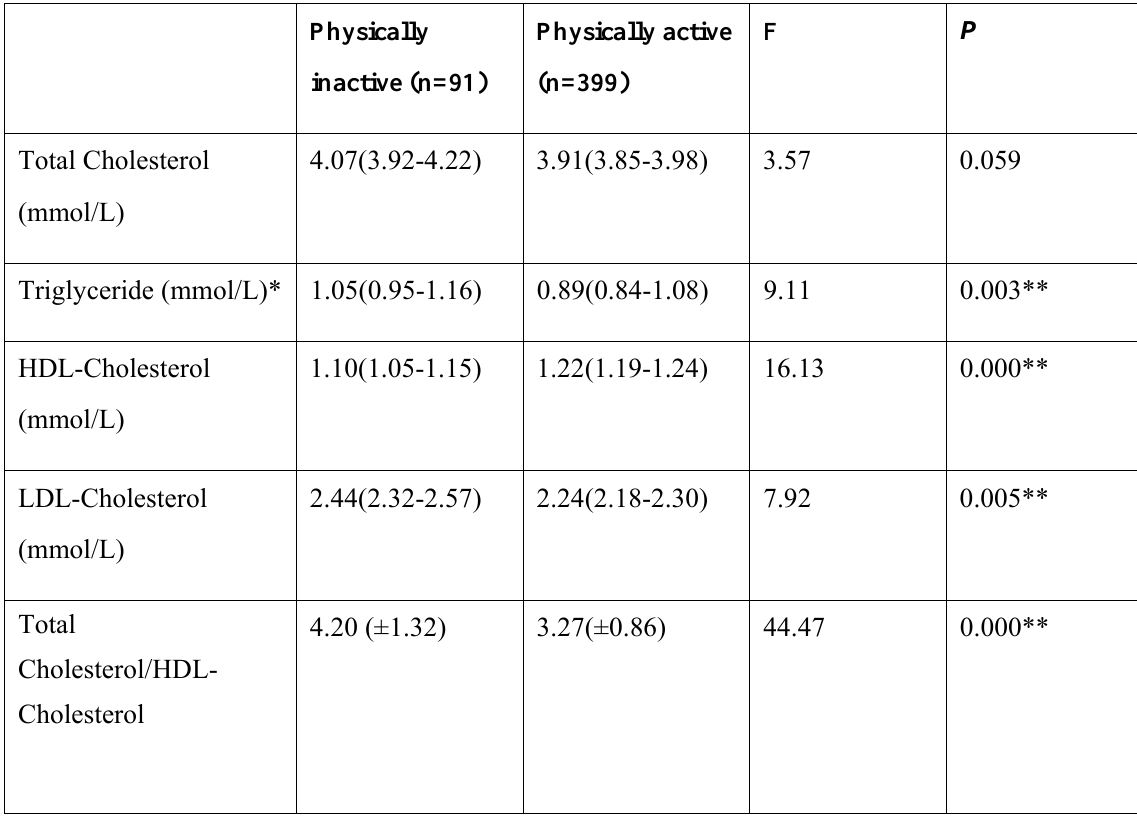
Table 2. Analysis of covariance assessing the effects of physical activity using lipids as dependent variables, physically activation group as fixed factors, and age as a covariate (MANCOVA). TC/HDL-C between groups were determined by independent samples t